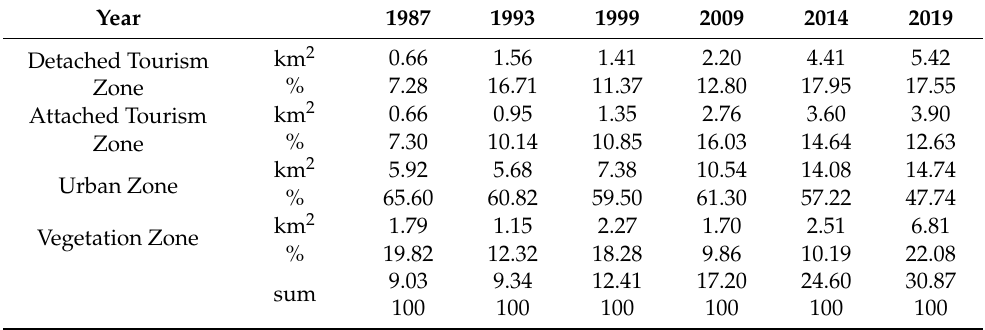
Table 6. The built-up area in each of the main zones in the study area